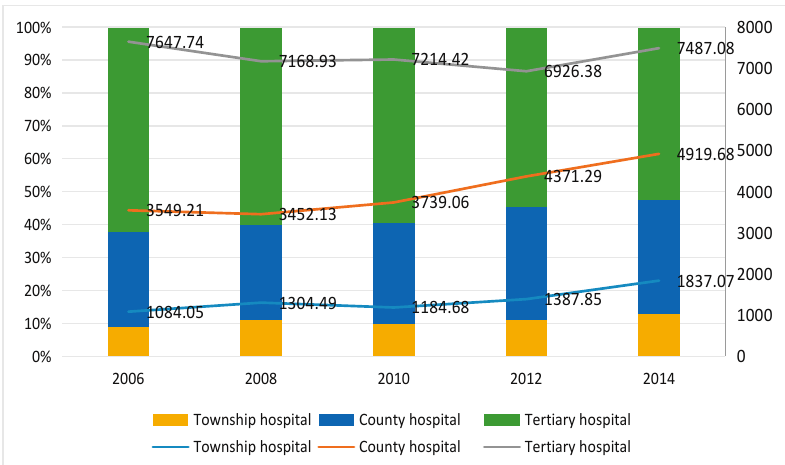
Figure 1. The adjusted hospitalization expense per capita in different levels of medical institutions and the distribution (¥). The lines show the adjusted data of hospitalization expense per capita in different levels of medical institutions. The bar chart shows the distribution of the proportion of each level hospital expense in total expense.